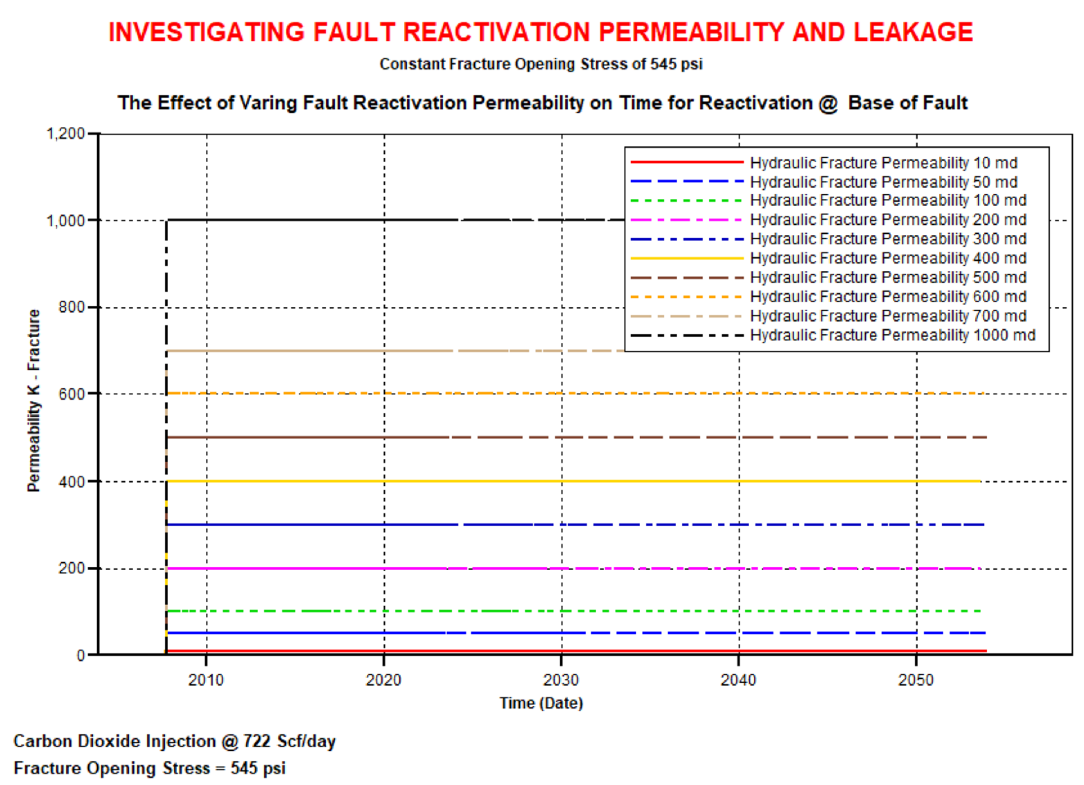
Fig. 18 The effect of varying hydraulic fracture permeability on the time taken for reactivation at the base of the